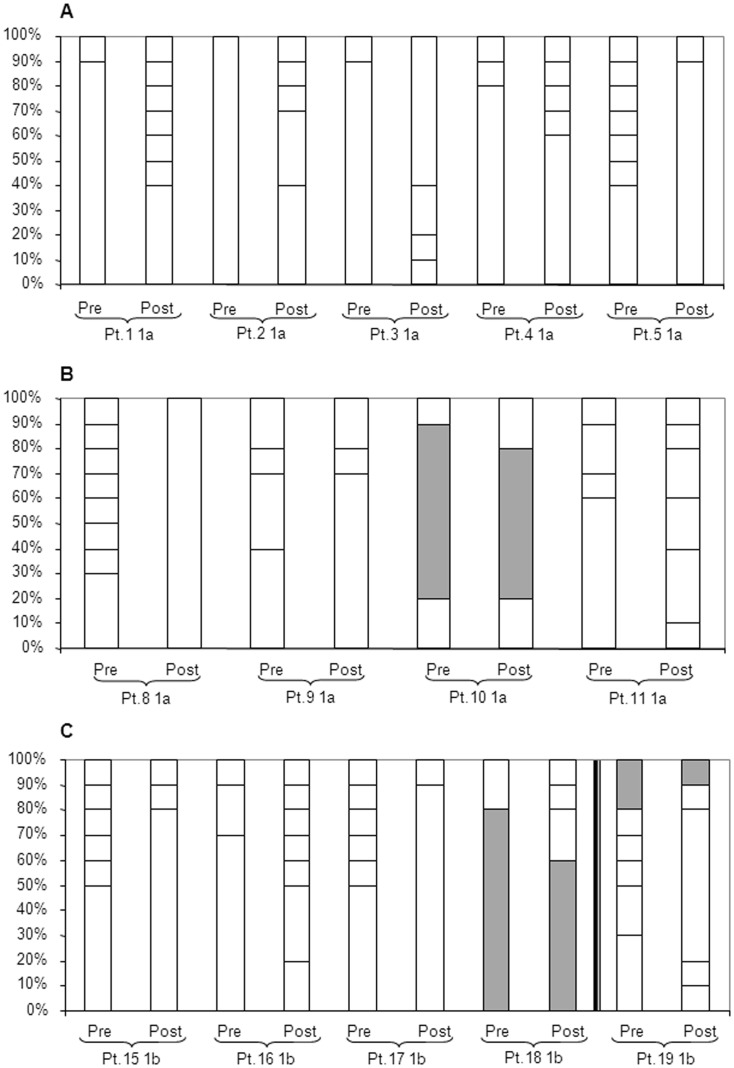
Number of variants comprising the NS3 protease domain quasispecies (amino acid) in pre- and post-treatment samples in 14 non-SVR patients.Vertical bars: number of viral variants/sample. Y-axis: percentage of each sequence in respect to the total population (10 clones). Panel A: TEL-treated GT1a patients (n = 5). B: BOC-treated GT1a patients (n = 4), C: TEL- (n = 4) and BOC-treated (n = 1; Pt. 19) GT1b patients. Shadings indicate identical clonal sequence in pre- and post-sample.